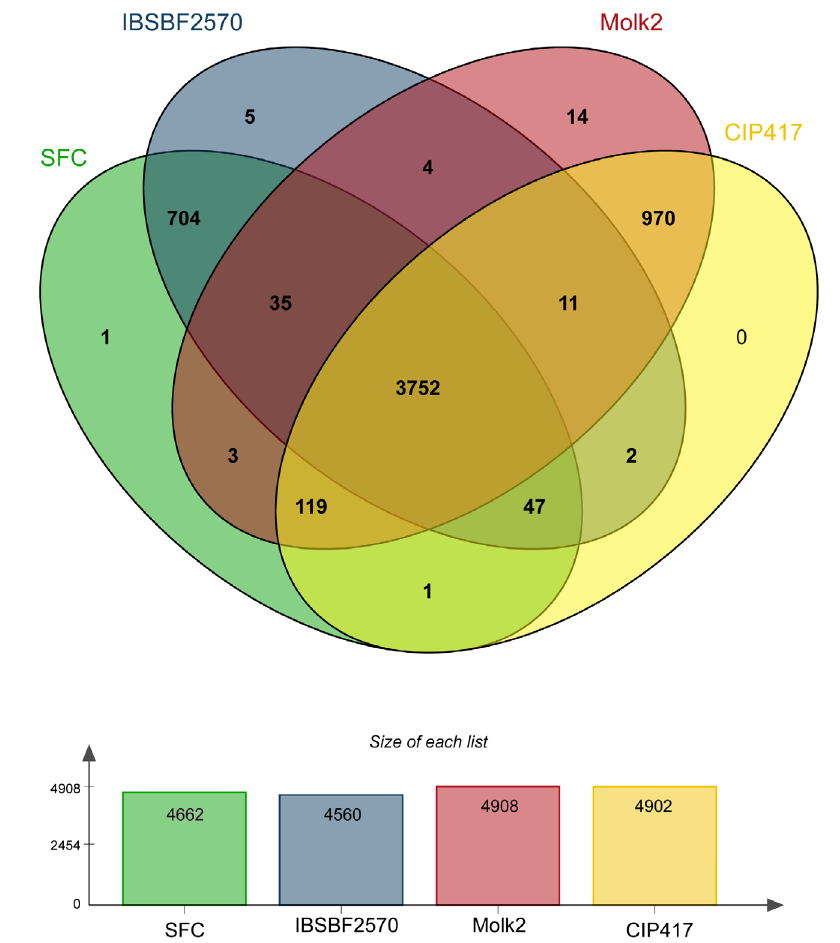
Figure 3 – Venn diagram showing clusters present in the genome of isolates of Ralstonia solanacearum causing Sergipe facies (SFC and IBSBF2570) and Bugtok disease (CIP417 and